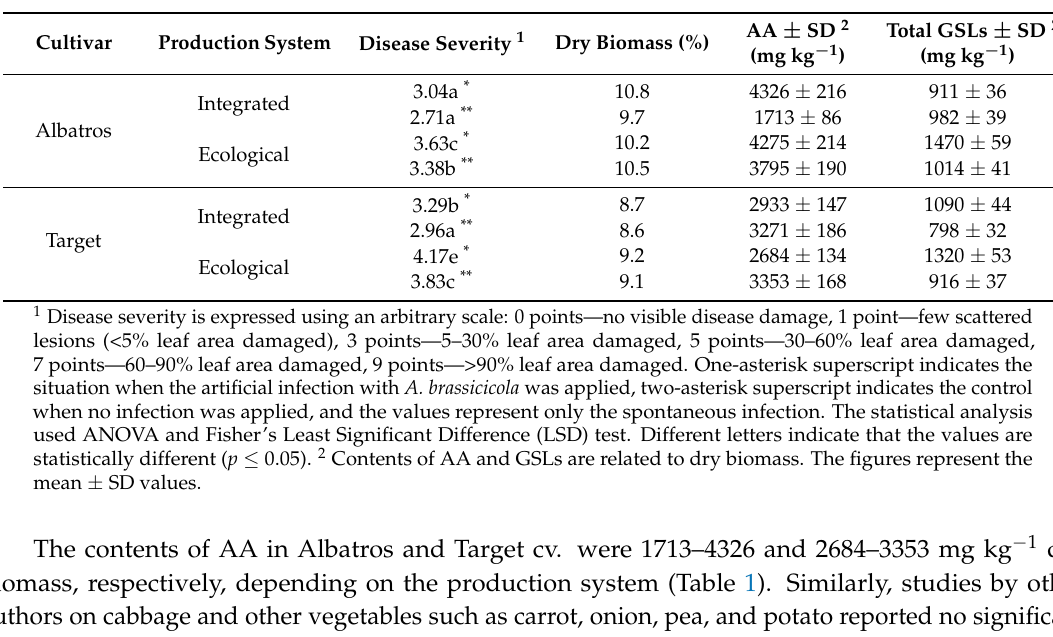
Table 1. Effect of production system and artificial fungal infection on the content of ascorbic acid (AA) and glucosinolates (GSLs) in Albatros and Target cultivars